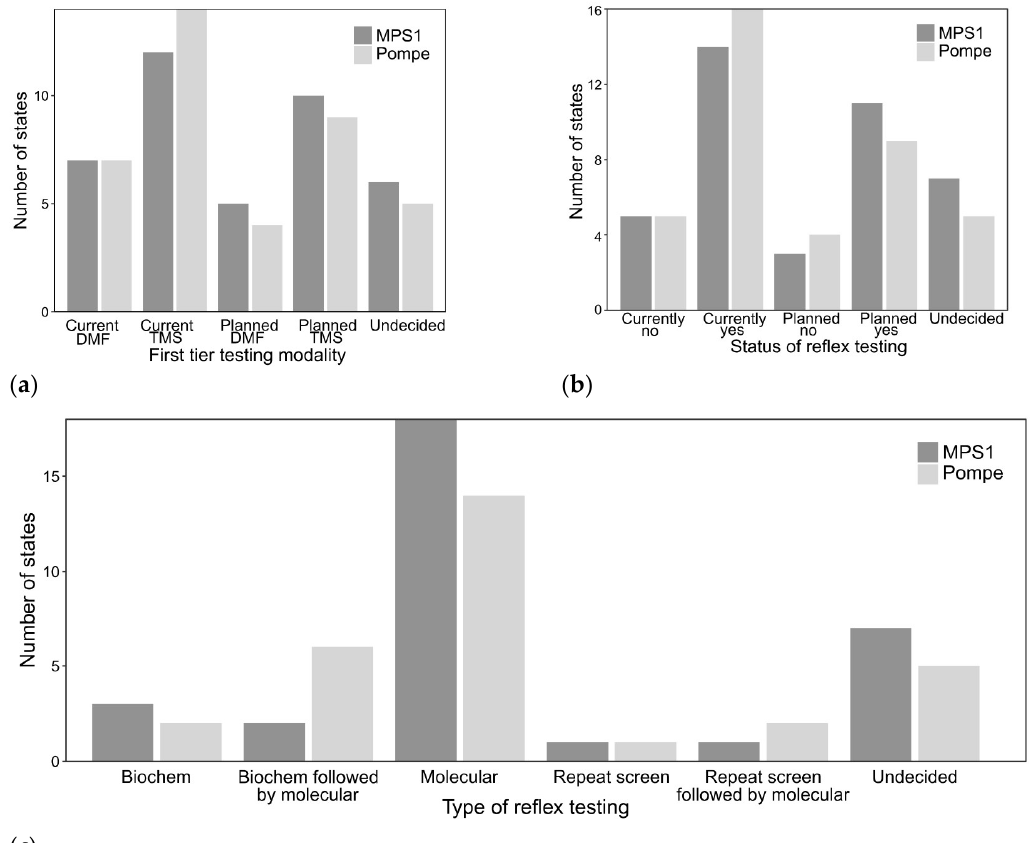
Figure 3. First-tier NBS and reflex testing modality for MPSI (dark gray) and Pompe disease (light gray). ( a ) First-tier testing modality divided between current screening vs. planned screening with either tandem mass spectrometry (TMS) and digital microfluidics (DMF); ( b ) Distribution whether